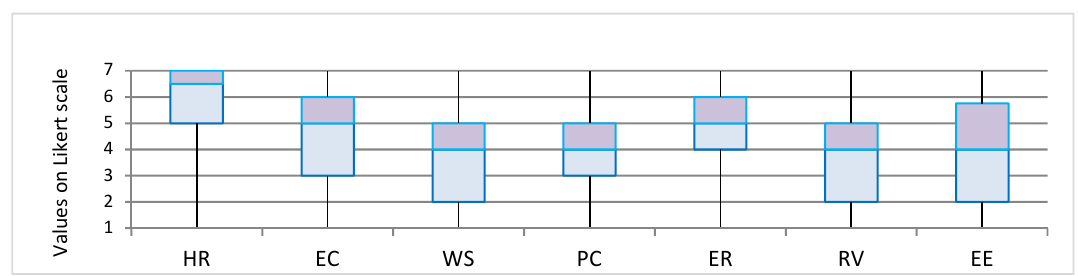
Figure 7. Box-plot for the utility of WrGIs/SuDSs perceived by stakeholders on a Likert scale from 1 (very low) to 7 (very high): HR (flood risk control), EC (erosion control), WS (water storage), PC (pollution control), ER (environmental restoration), RV (recreational value), EE (economic efficiency).